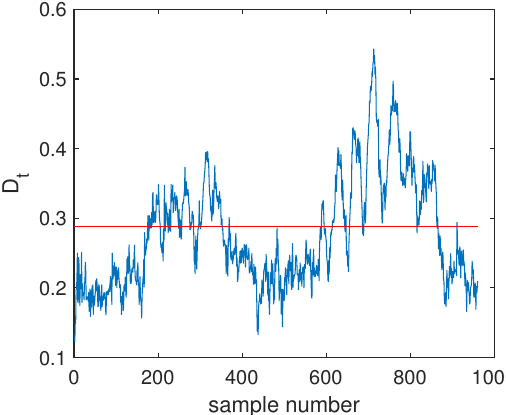
Figure 5. Fault detection chart of fault F10 based on SVDD.